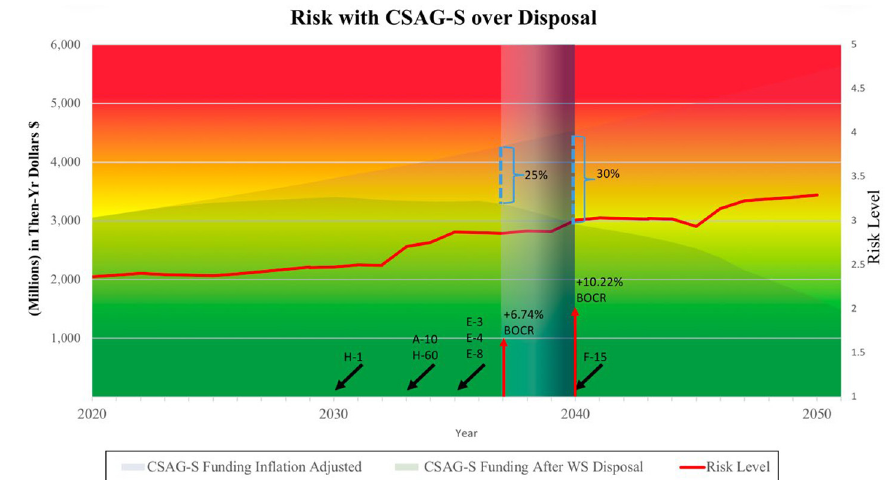
Figure 12. Possible organic supply chain risk management reporting and